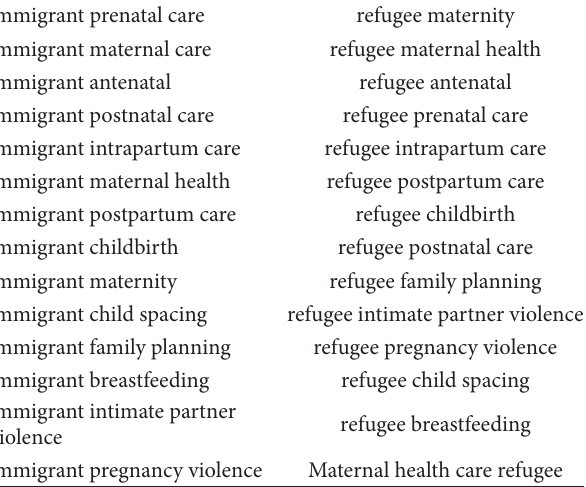
Table 1: Search terms used. immigrant prenatal care refugee maternity immigrant maternal care refugee maternal health immigrant antenatal refugee antenatal immigrant postnatal care refugee prenatal care immigrant intrapartum care refugee intrapartum care immigrant maternal health refugee postpartum care immigrant postpartum care refugee childbirth immigrant childbirth refugee postnatal care immigrant